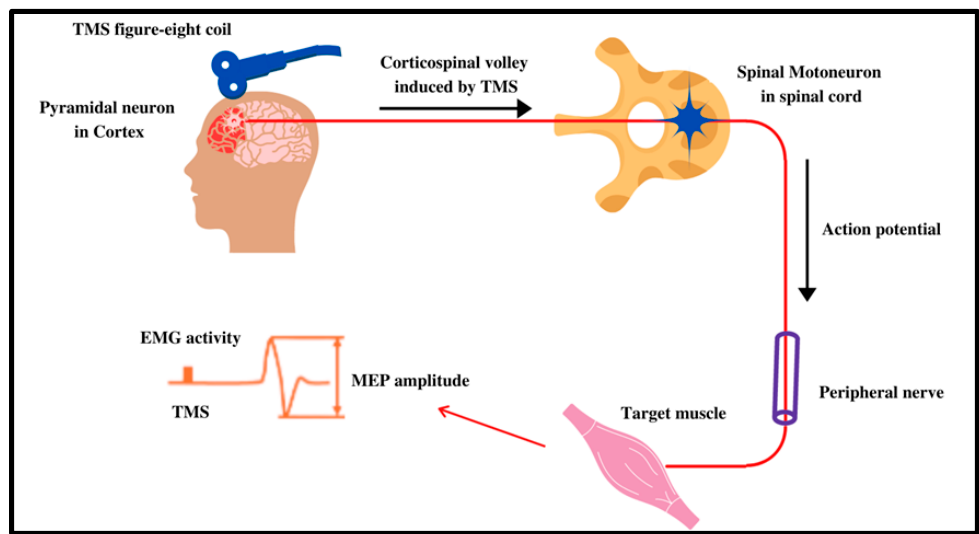
Figure 3. Mechanism of action of TMS: To quantify the strength and confirm the activity of the TMS, MEPs are used. Once the TMS coil is fired, cortical neurons signal via the corticospinal tract to the stimulated targeted muscle activity. These MEPs can be quantified as excitatory or inhibitory depending on the muscle’s movement or lack thereof. Adapted from Klomjai et al. [24].